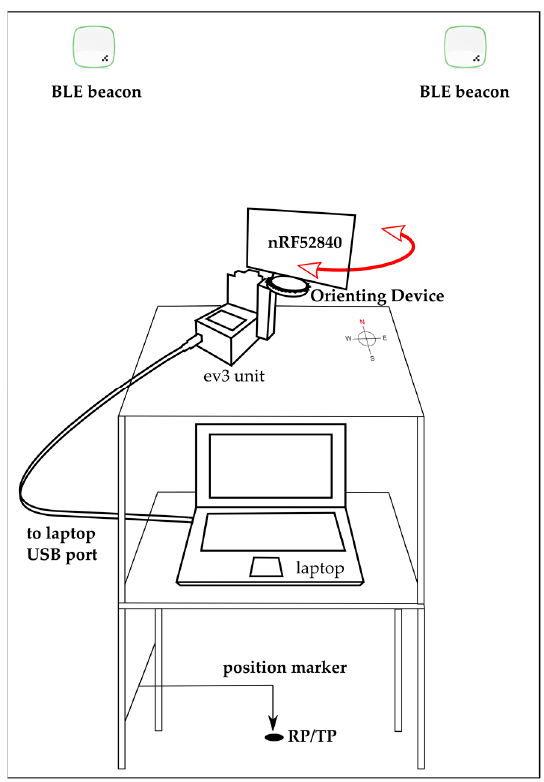
Figure 2. Block diagram of the acquisition platform showing the EV3 unit with the orienting device (OD), the receiver (nRF52840 DK) and the laptop computer.